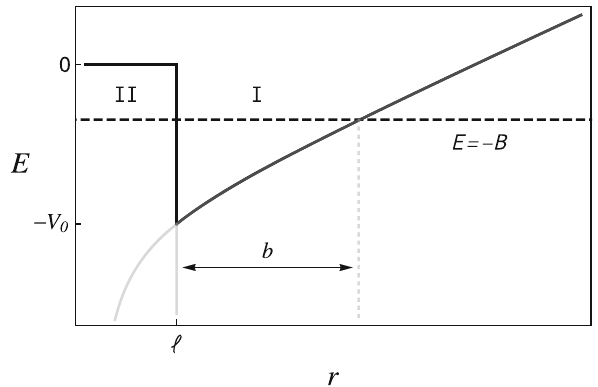
Fig. 2 Potential between diquarks as a function of their distance. Here b = ( V 0 − B )/ν is the classical turning point. The diquark–antidiquark pair is produced in region I. If a quark tunnels through the barrier or if E > 0, color can be rearranged and the state decays into a meson